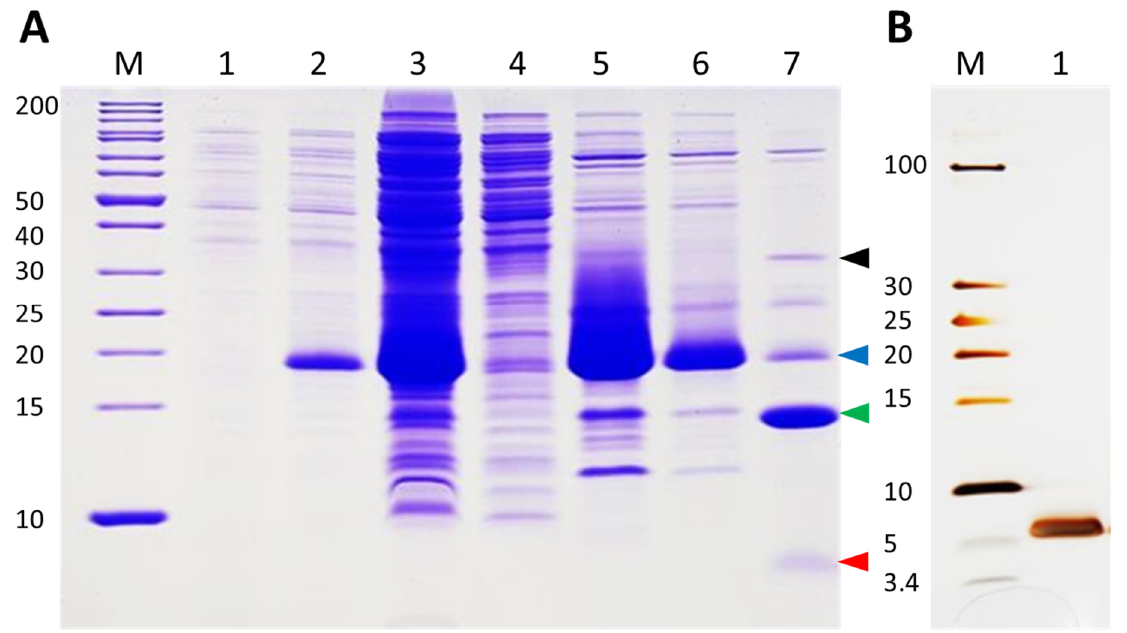
Figure 8. DEFL expression in E. coli. ( A ). SDS-PAGE (Coomassie blue stained gel) analysis of the